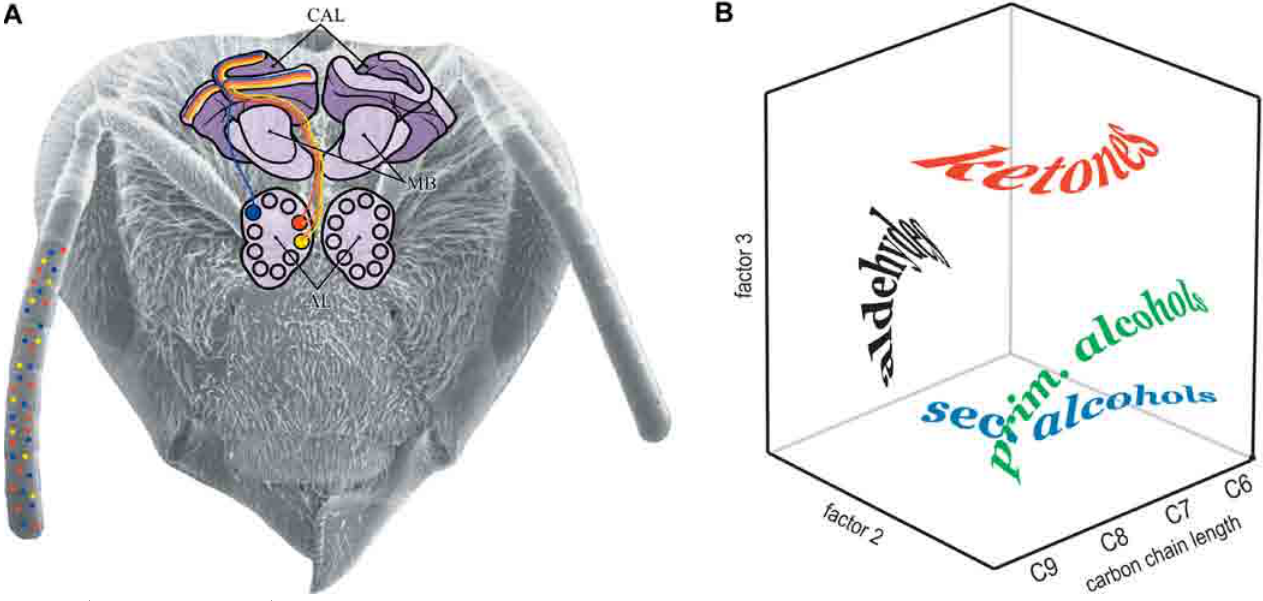
Figure 3. Neuronal Odor Coding and Odor Space in Bees (A) Schematic view of odor processing in the honeybee brain. Some 60,000 odorant receptor cells are distributed along the antenna. These belong to several different types (illustrated with different colors), each responsive to a different set of chemicals. Axons from like receptors project to one or a few glomeruli in the antennal lobe. The glomerular map is organized so that similar odors are mapped to nearby spatial locations (yellow and red), while dissimilar odors stimulate glomeruli located further apart (blue). Axonal projections extend from the antennal lobe to higher processing centers, such as the calyces (CAL) of the mushroom bodies (MB). Some such projections might relay relatively unprocessed sensory information to the mushroom bodies (yellow, red, and blue), while others contain processed information based on lateral interactions between glomeruli (orange, between the yellow and red projections). (B) Putative three-dimensional odor space for bees. Guerrieri et al. [8] trained bees to associate one of 16 odors with a sucrose reward, and then faced bees with the other 15 odors, to see how similarly bees judged these to the training odor. Distances between these substances in a three-dimensional space predict the bee-subjective similarity of the odors. The most important axis corresponds to the carbon chain length of the substances tested; the other two dimensions separate substances according to functional group. Each word illustrates the spatial distribution of a group of substances with like functional group, but varying in chain length. (Image based on Figure 6 in